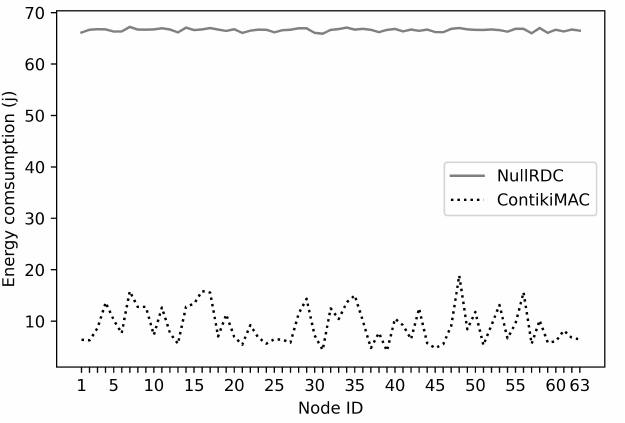
Figure 17. Consumed energy at CPU on , CPU lpm , R x , T x , and Rx modes. Note that Wismote is powered by batteries with a 2xAA (3.0 V) [86]. The nominal charge capacity of these batteries is approximately 1300–3000 mAh. The nominal charge capacity is assumed to be 2500 mAh. To convert mille Ampere Hour (mAh) into Joules, the unit conversion factor is 3600 [87]. Therefore, the energy per Wismote can be calculated as follows: Energy = (nominal charge capacity × 10 − 3 × Voltage × Time) Joules. Thus, the Energy = 2.5 × 3 × 3600 = 27, 000 Joules. Utilizing ContikiMAC as an underline RDC protocol to simulate 64 nodes, the average consumed energy is 9.2 Joules per